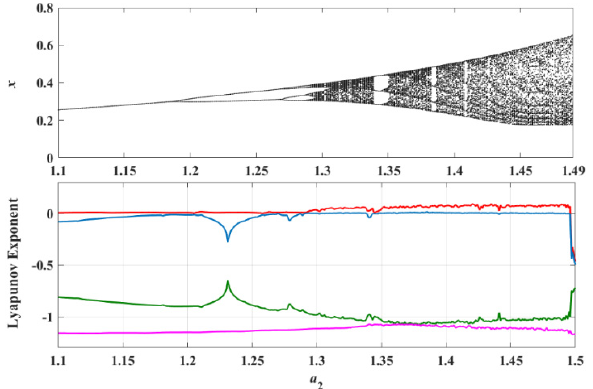
Figure 9. The bifurcation diagram and Lyapunov exponent spectrum of the HNN varying with a 2 ∈ [1.1, 1.5].